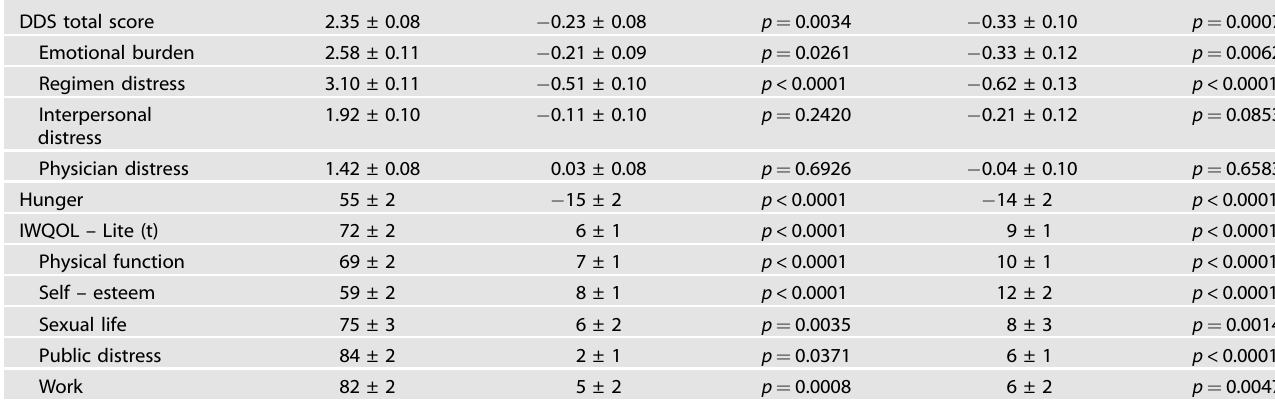
Table 2. Change in diabetes distress scale, hunger, and quality of life with a 24 week scalable, virtually delivered diabetes-tailored weight management